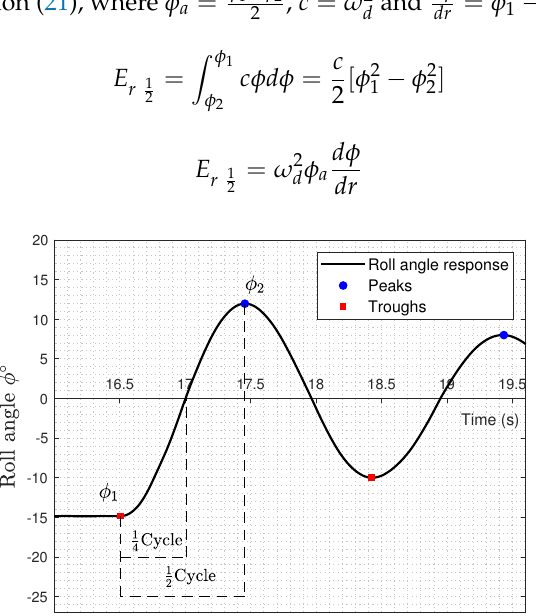
Figure 3. Annotation of peak and trough amplitudes for half cycle, test case 8, see Section